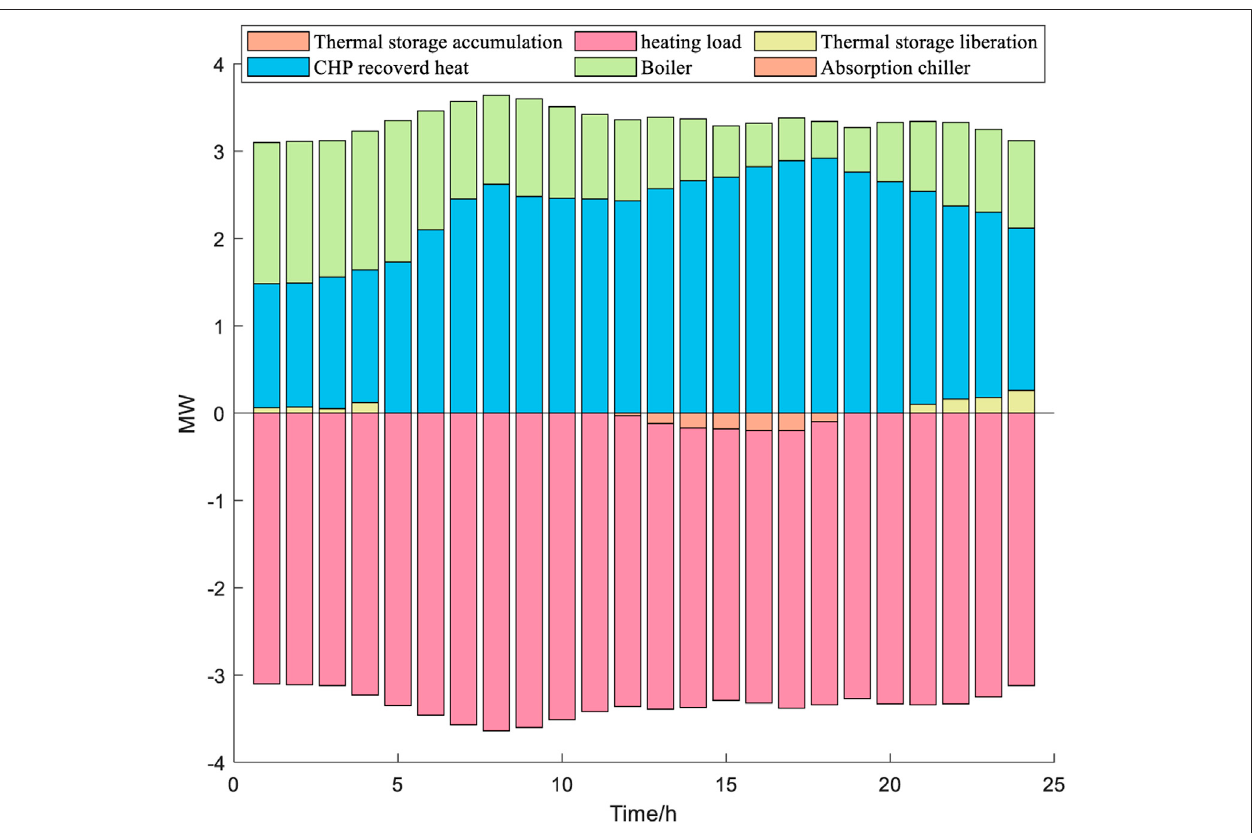
FIGURE 8 | Diagram of optimization scheduling results of thermal